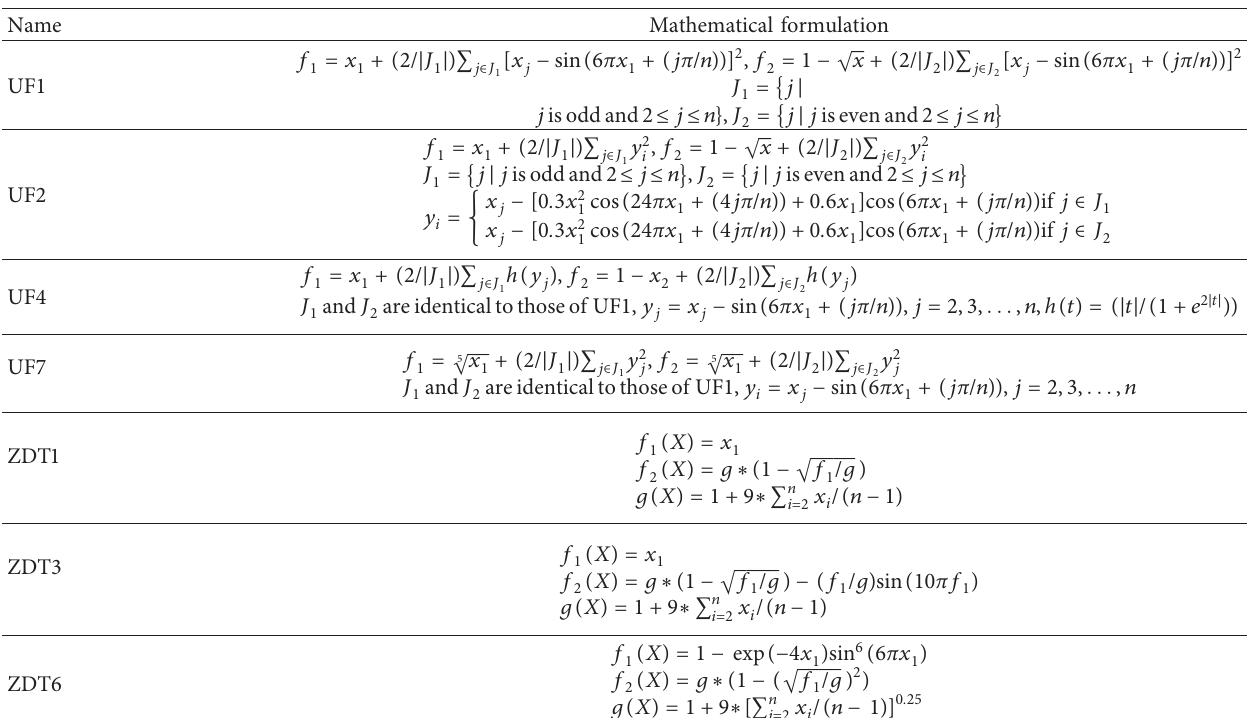
Table 2: Test function